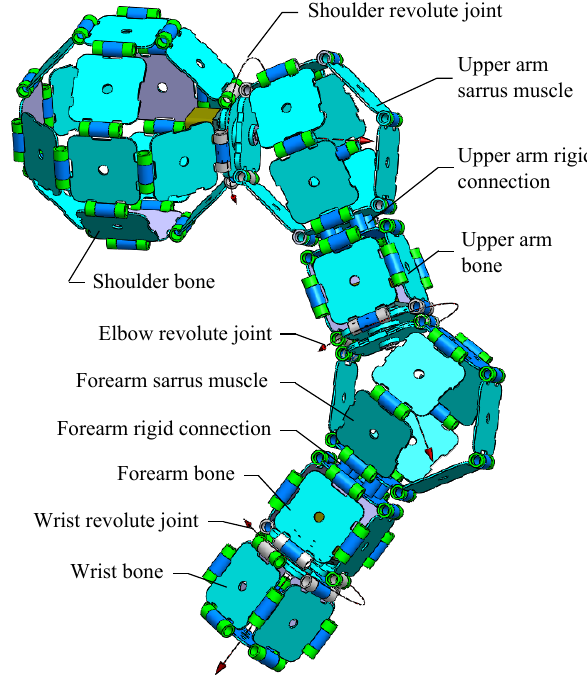
Figure 4. A bio-inspired modular 5-DOF robotic